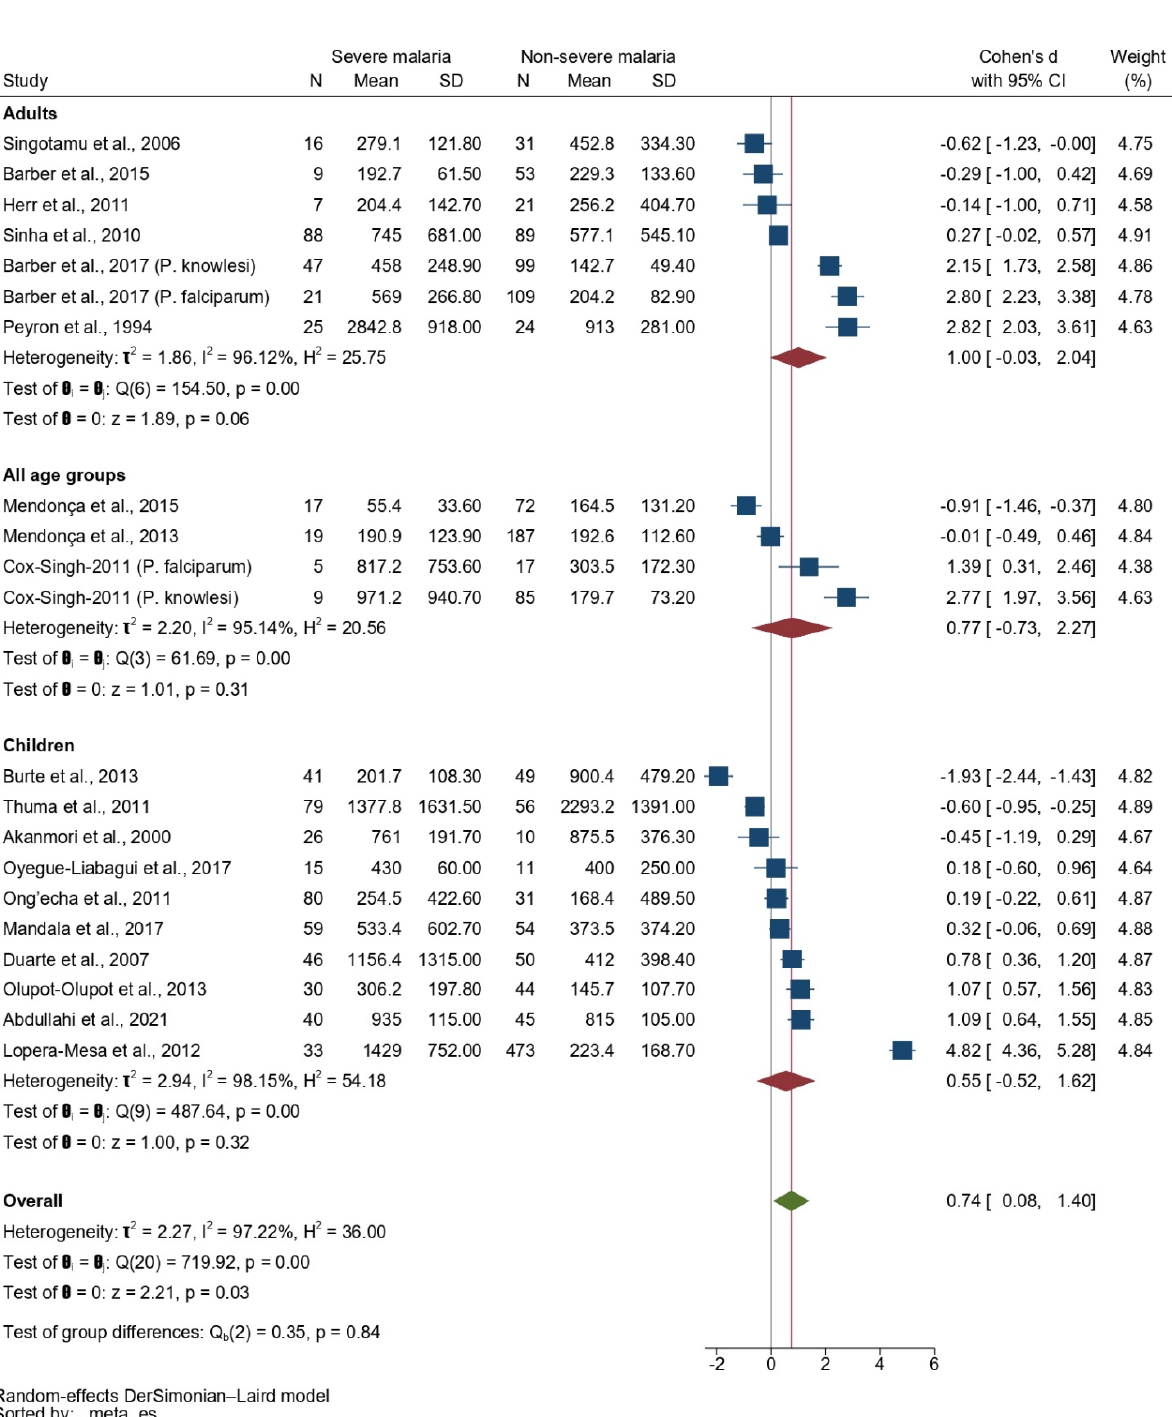
Figure 6. Forrest plot showing the SMDs of IL-10 levels between patients with severe malaria and those with non-severe malaria by age group. Abbreviations: CI, confidence interval; SD, standard deviation. Symbols: blue square, point estimate (SMD of IL-10); green diamond, pooled effect estimate (pooled SMD of IL-10); red diamond, pooled effect estimate in each